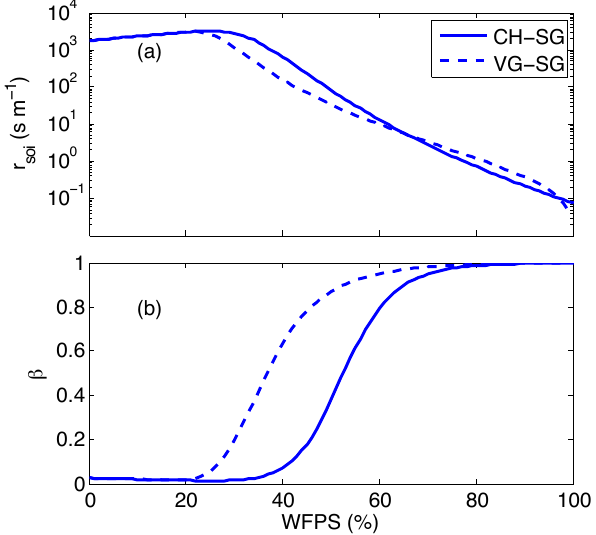
Fig. 8. An assessment of the TSCV thickness impacts on (a) pre- Figure 8 An assessment of the TSCV thickness impacts on (a) predicted soil resistance 2 dicted soil resistance and (b) evaporation efficiency. The CH hy- and (b) evaporation efficiency. The CH hydraulic property parameterization listed in 3 draulic property parameterization listed in Table 5 is used in the calculation. For all cases here, we assumed r a = 50sm − 1 and Table 5 is used in the calculation. For all cases here, we assumed r D 0 =2.4 × 10 − 5 m 2 s − 1 D 2.4 ! 10 " 5 m 2 s -1 . 5 50 s m -1 , 5 0 = a = =1.75cm. 1